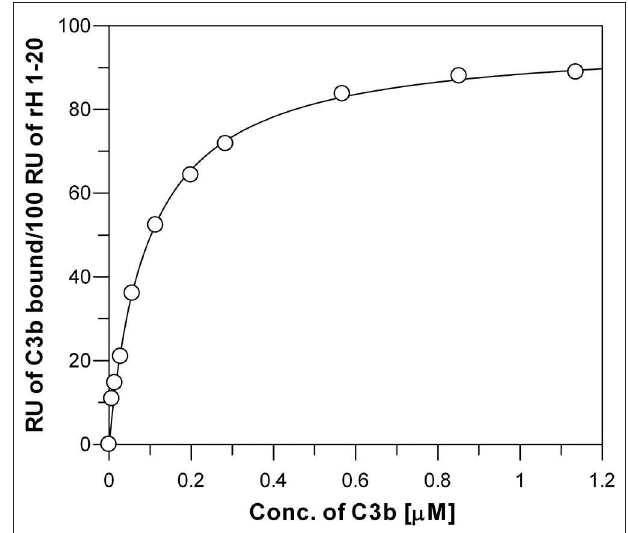
FIGURE 5 | Measurement of the affinity between C3b and surface-bound full-length Factor H. Each data point represents the equilibrium saturation level from one individual ligand binding curve from experiments like those described in Figure 3 . Recombinantly expressed rH 1-20-6xHis was bound to Ni-NTA BIAcore chip and different concentrations of C3b in HBS-P were injected over the chip. The K d (0.095 + 0.005 µ M) was determined by fitting the data using non-linear regression to a single site ligand binding equation (Bound = (Capacity*[Free])/( K d + [Free])) using GraFit 5 program ( Erithacus ).